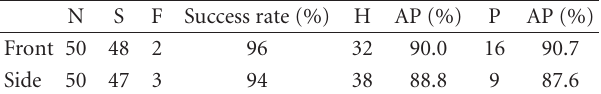
Table 9: The results of repeated experiments using patches in Figure 12 (N: the number of experiments; S: success; F: Fail; H: the number of incidences of “Hitting” type collision; P: the number of incidences of “Pushing” type collision; AP: the average probability values given by the system for each type of collision).